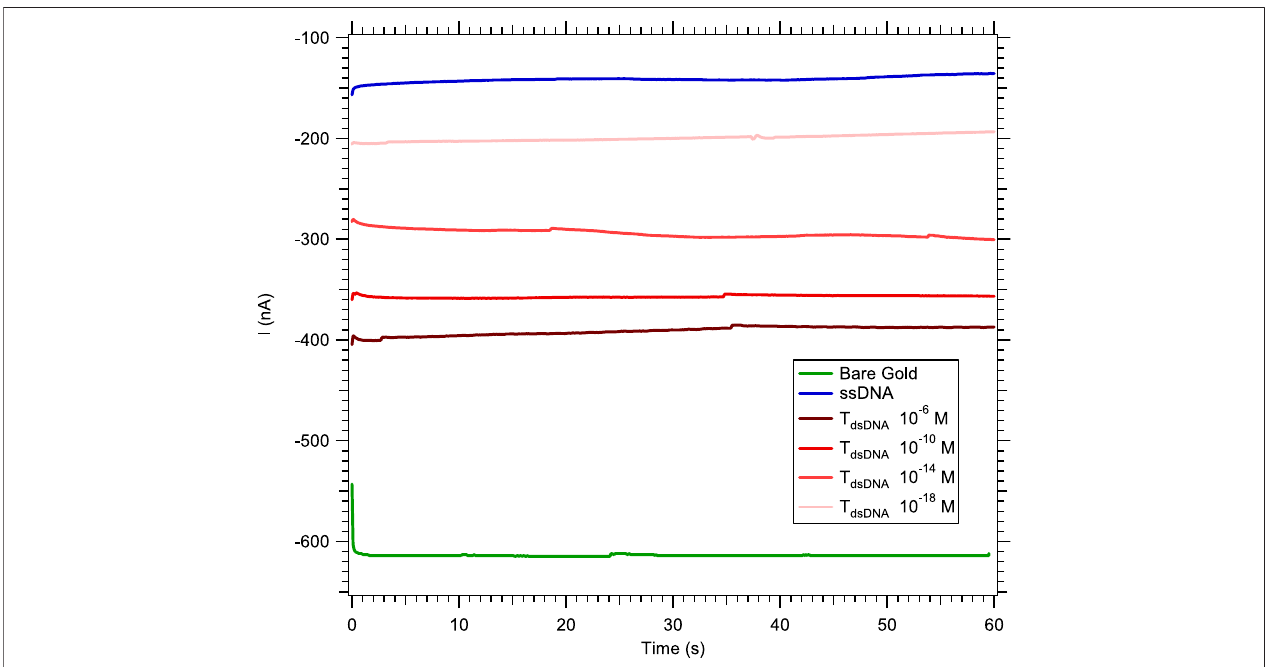
FIGURE 4 | Chronoamperometry at − 0.2 V in 3 mM [Fe (III) (CN) 6 ] 3 − /[Fe (II) (CN) 6 ] 4 − and 0.5 M NaCl with 5 µM MB and a 0.5 μ L.s − 1 fl ow rate, showing the absolute value of the current increasing with the DNA target concentration.